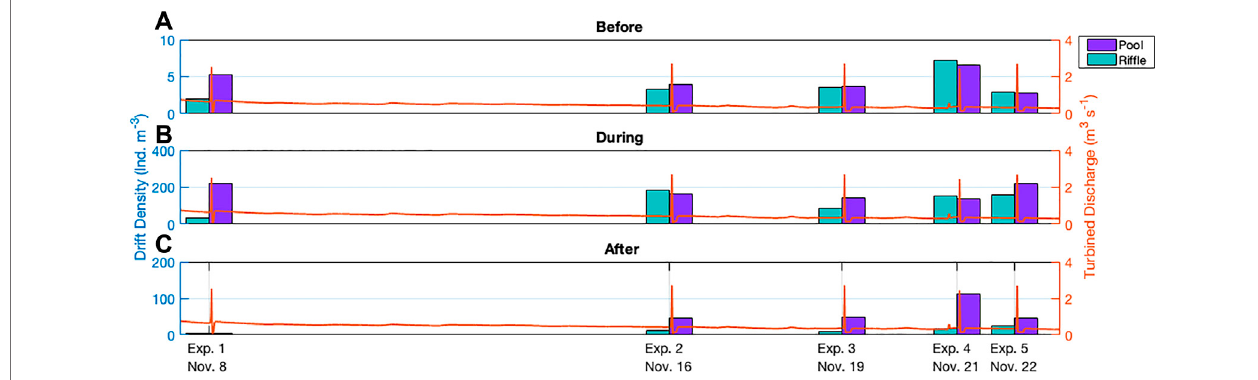
FIGURE3| Driftdensitymeasured atthecentralnet(net2)forthedownstreamrif fl eandpoolhabitats (A) before(sample0), (B) during(samples1 – 3),and (C) after (samples4 – 5)hydropeaking,asexample.Sampleswerecombinedtobettershowtrendsintheindividualhabitatsandaccountforslightvariationsinpeaktiming.Theleft y -axis shows drift density (ind. m − 3 ) and varies for each stage of the peak. The right y -axis shows the turbined discharge (m 3 s − 1 ). The x -axis indicates the timing of the experimental